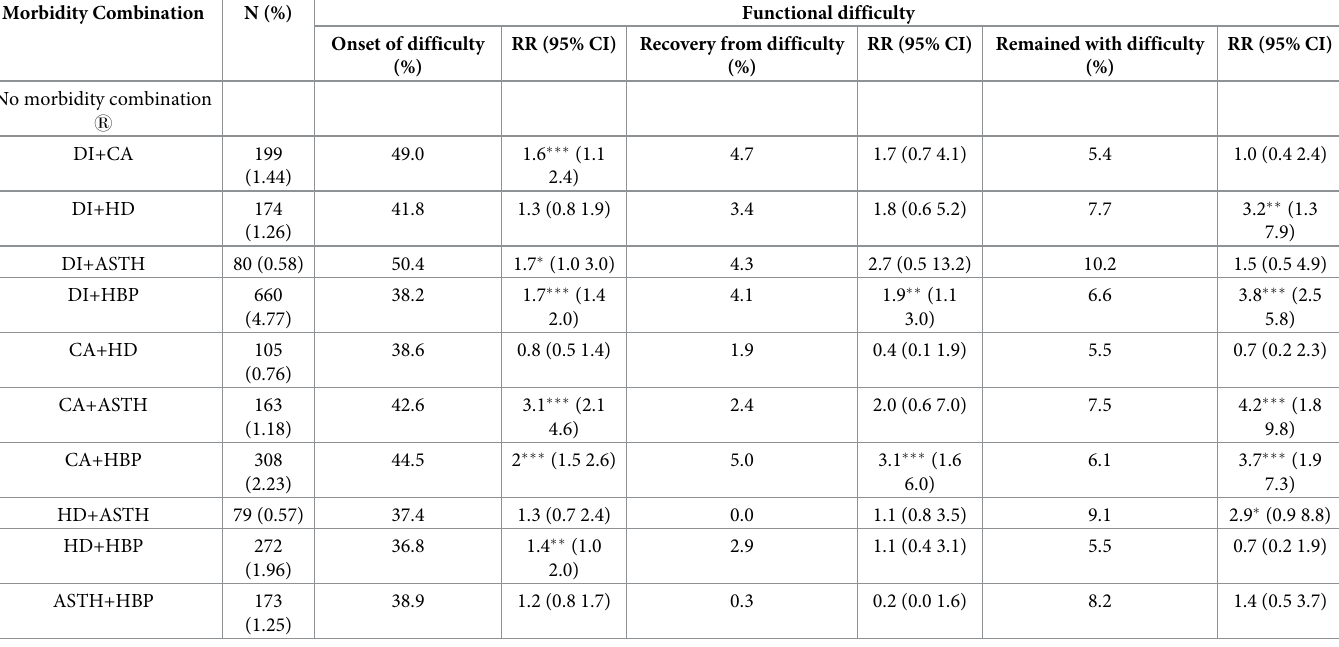
Table 4. Percentage distribution, bivariate and multivariable estimates of changes in functional difficulty (ref: No functional difficulty in both rounds) by morbid- ity dyads. Morbidity Combination N